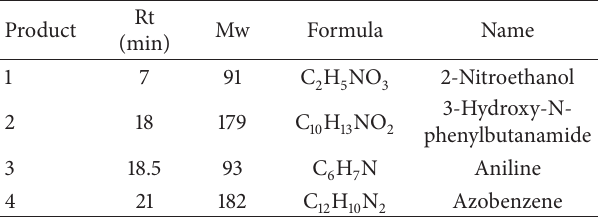
Table 1: Identification of the small molecular intermediates of aniline during the photoreaction by GC/MS.